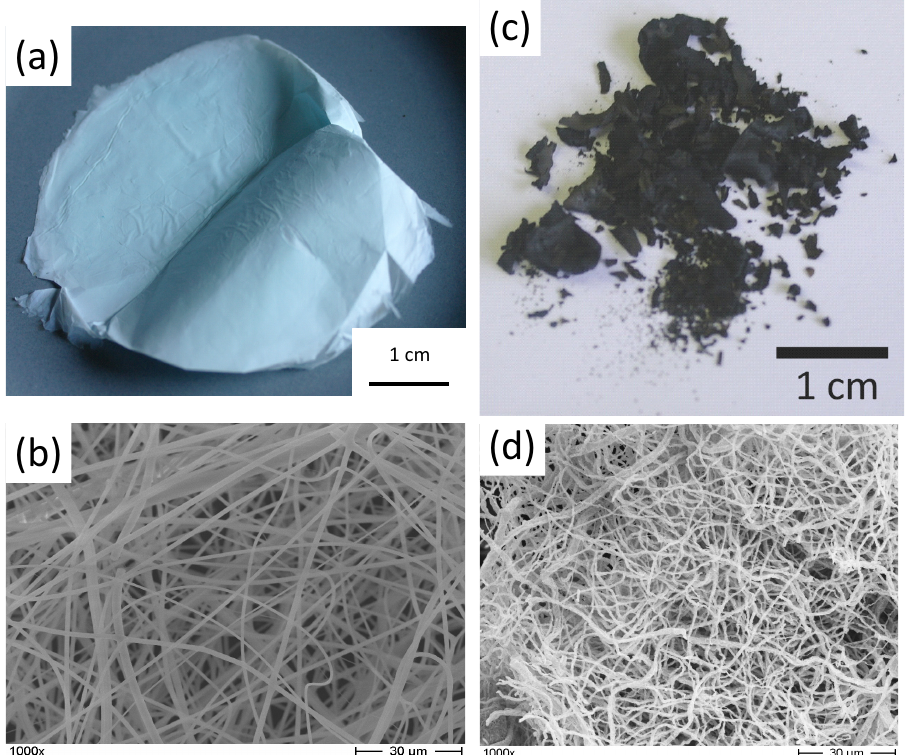
Figure 1. ( a ) As-spun (green) nanofiber mat after the electrospinning stage, ( b ) Scanning electron microscopy (SEM) image of the as-spun Bi-2212 nanowires, ( c ) fully reacted Bi-2212 nanofiber mat sample, and ( d ) SEM image of the fully reacted Bi-2212 nanowires.